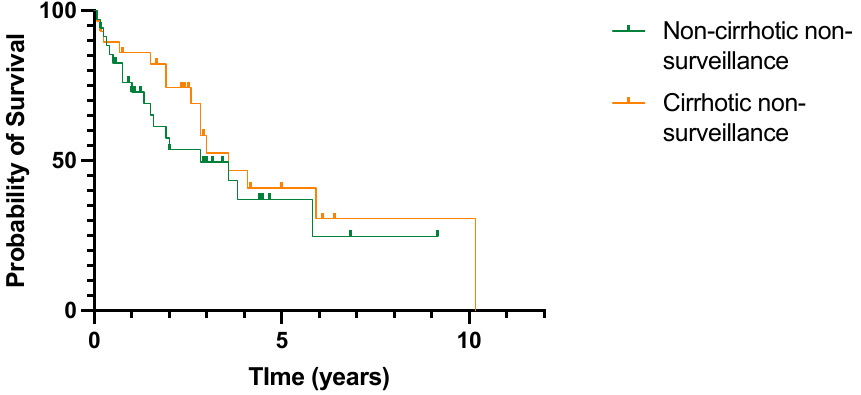
Figure 6. No difference in overall survival in patients with or without cirrhosis diagnosed with HCC outside cancer surveillance. All-cause mortality. p = 0.39 (log rank (Mantel – Cox) test). Table 2. Patient and tumour demographics with and without cirrhosis in the non-surveillance co- hort.